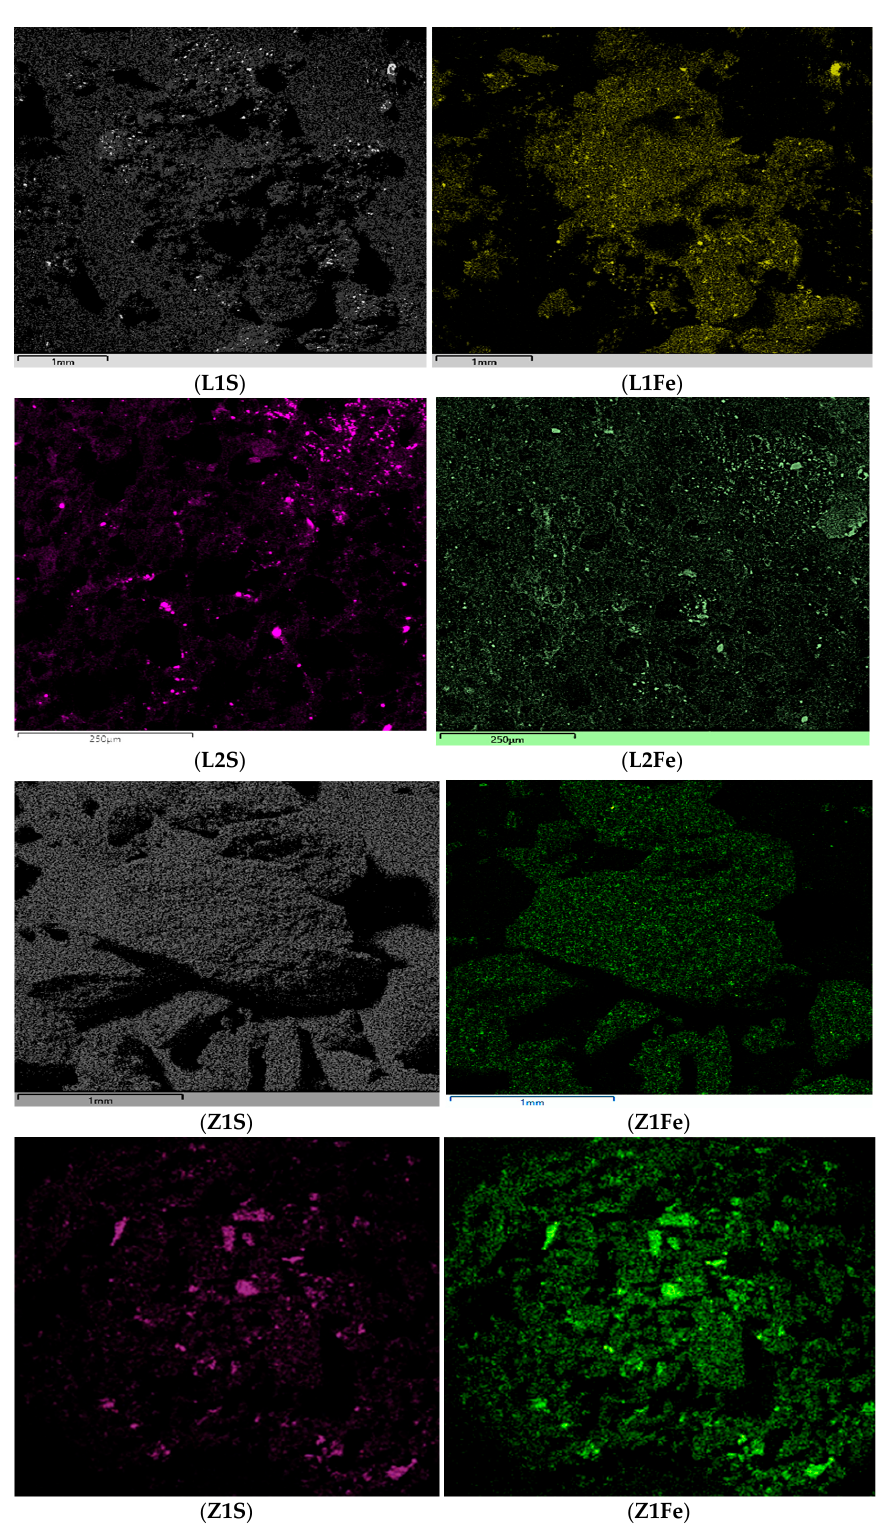
Figure 6. Microphotographs of the analyzed samples. Color mapping: purple for sulfur; yellow-green for iron.